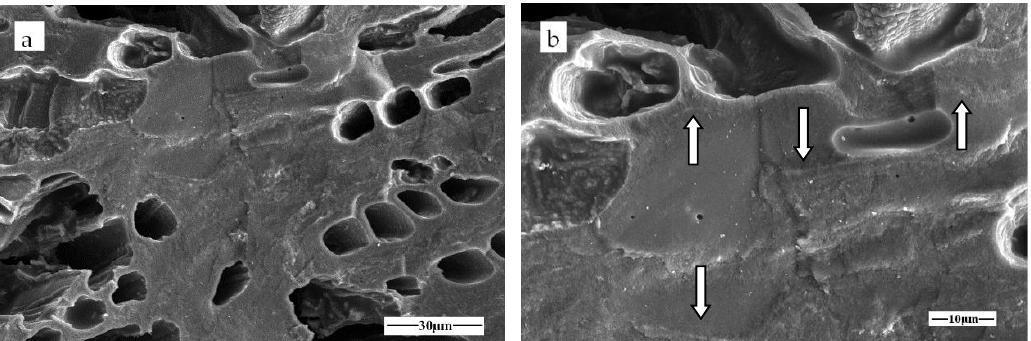
Figure 9. Morphology of the fracture surface of WCM-1.0 ( a ) Low-magnification SEM image; ( b ) High-magnification SEM image 3 mm.